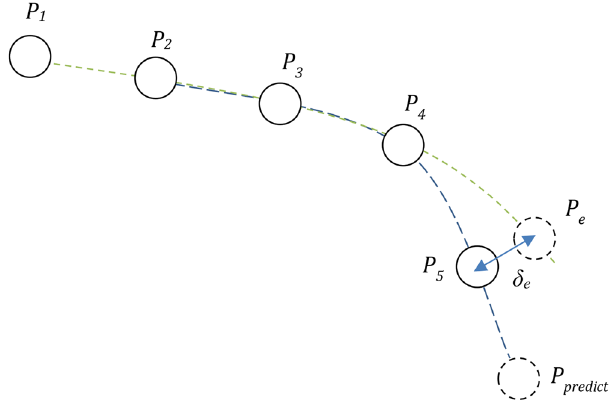
Figure 5: Prediction task